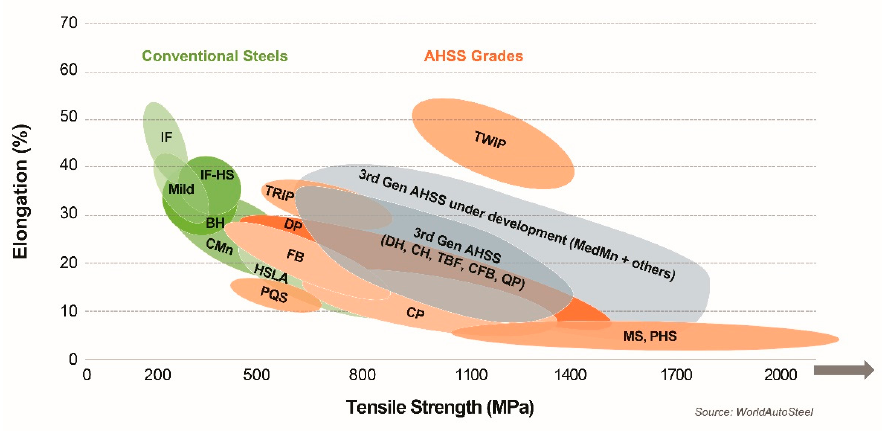
Figure 1. The GFD represents the strength and elongation of conventional and various categories of AHSS [9]. Courtesy of WorldAutoSteel.